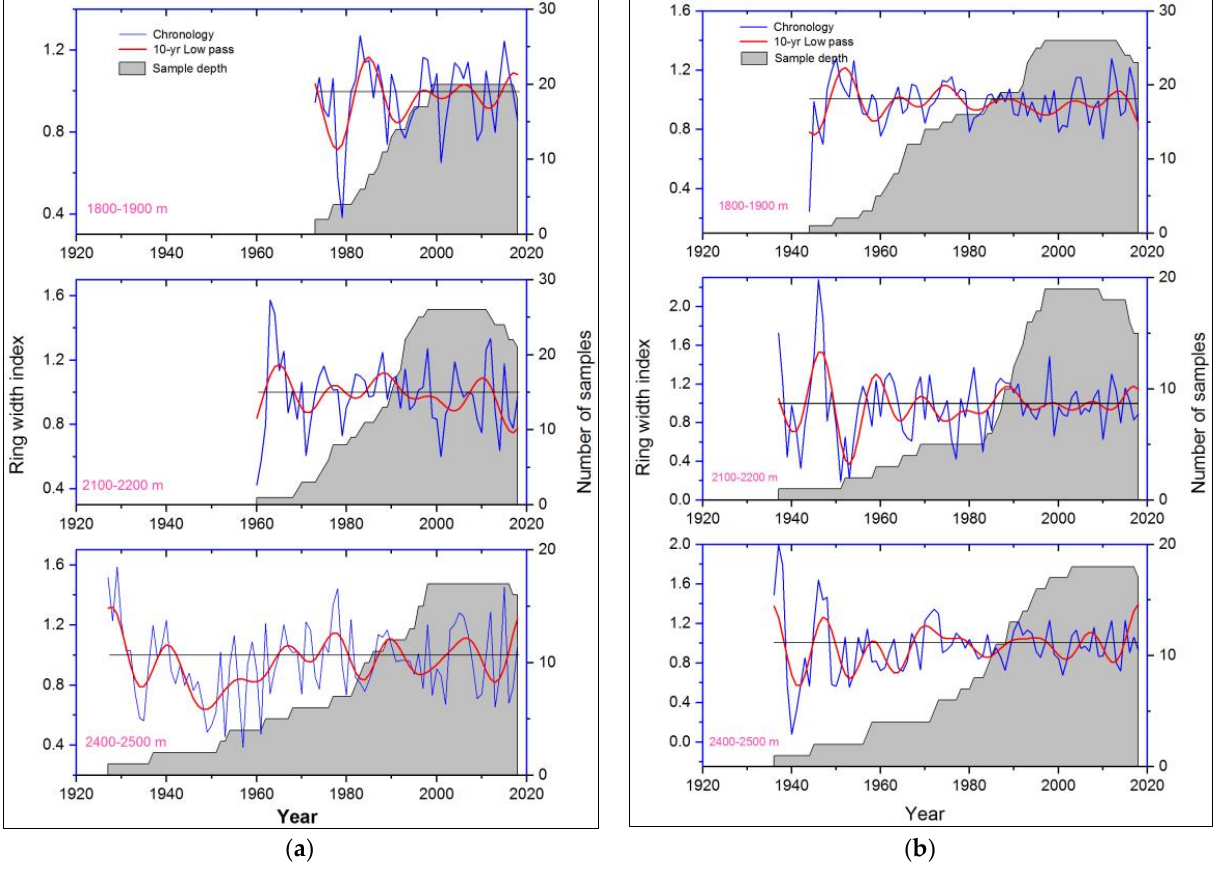
Figure 4. Tree-ring width chronologies of P. wallichiana along the elevation belts in the Makwanpur district: lower (1800–1900 masl), middle (2100–2200 masl), and upper (2400–2500 masl) elevation belts: ( a ) northeast aspect; ( b ) northwest aspect. Table 1. Overall statistics of tree-ring width data of P. wallichiana